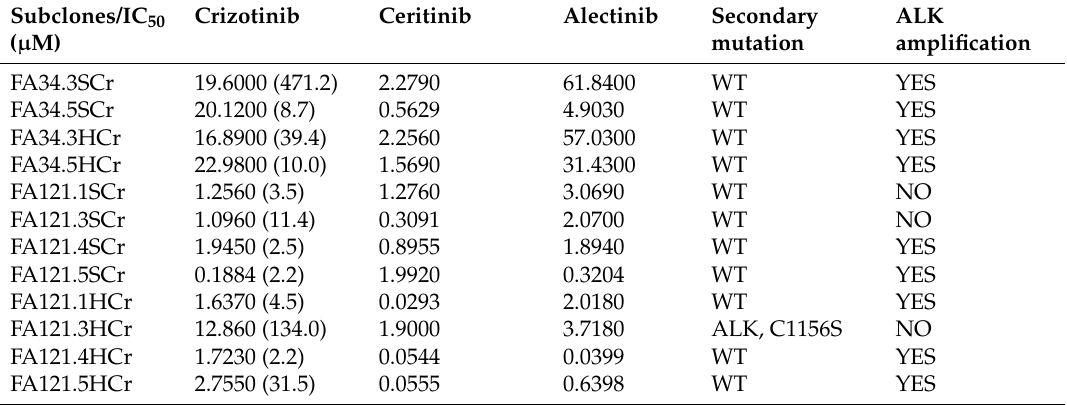
B . IC 50 values and the resistant mechanisms of different crizotinib-resistant subclones against the three ALK-TKIs tested.